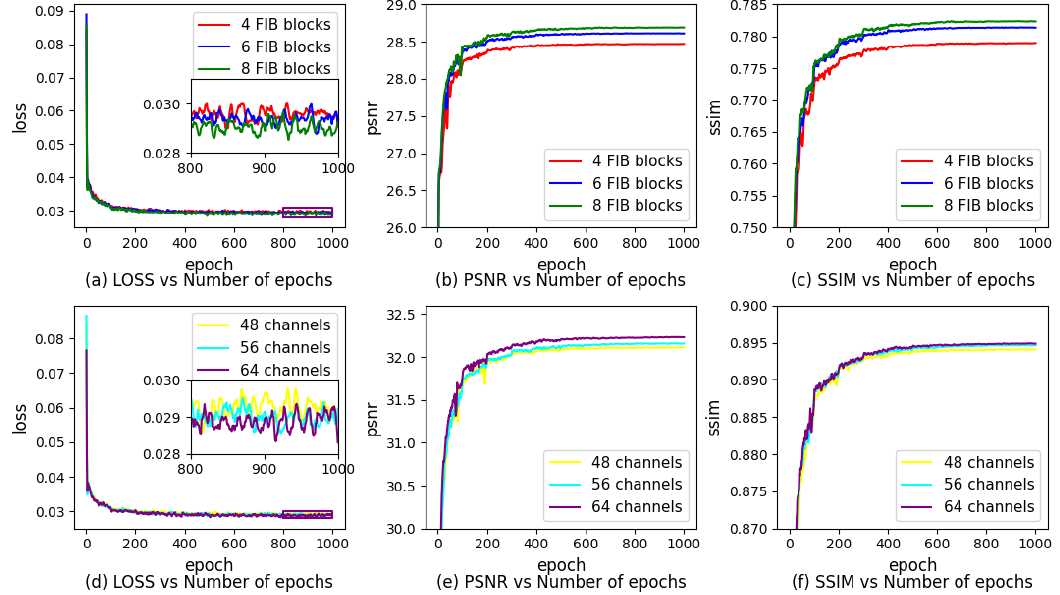
Figure 7. The influence of the number of FIBs on the model reconstruction effect. ( a ) LOSS vs. number of epochs; ( b ) PSNR vs. number of epochs; ( c ) SSIM vs. number of epochs. The influence of the number of channels in the FIB on the model reconstruction effect. ( d ) LOSS vs. number of epochs; ( e ) PSNR vs. number of epochs; ( f ) SSIM vs. number of epochs. Table 1. The influence of the number of FIBs on the model reconstruction effect.